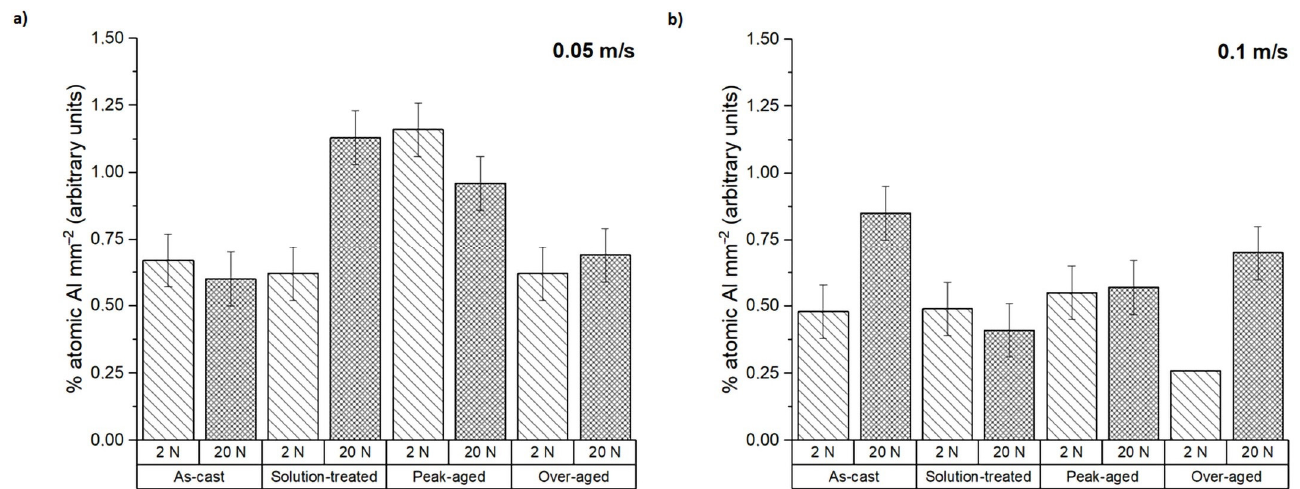
Figure 7. The atomic percentage of aluminum on the worn surface at sliding speeds of ( a ) 0.05 m s − 1 and ( b ) 0.1 m s − 1 .